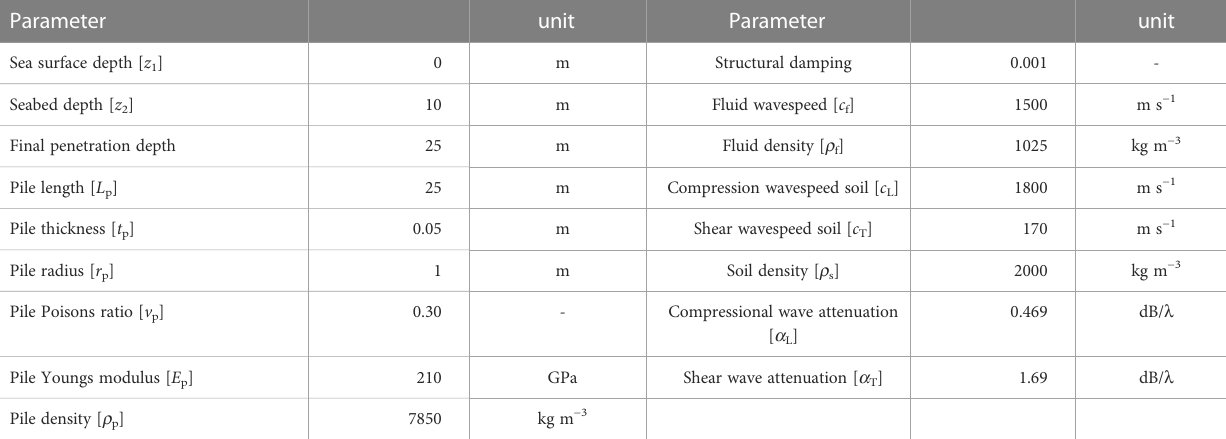
TABLE 1 Model properties for model veri fi cation in Section